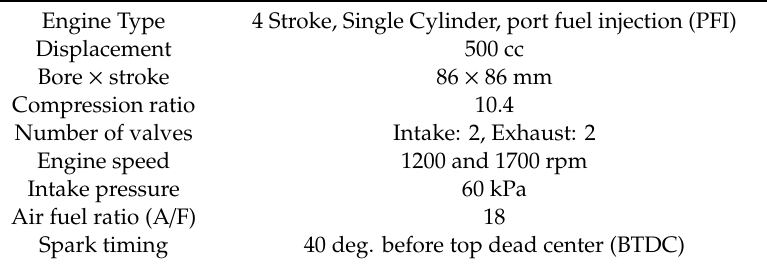
Table 1. Engine Specifications and operating